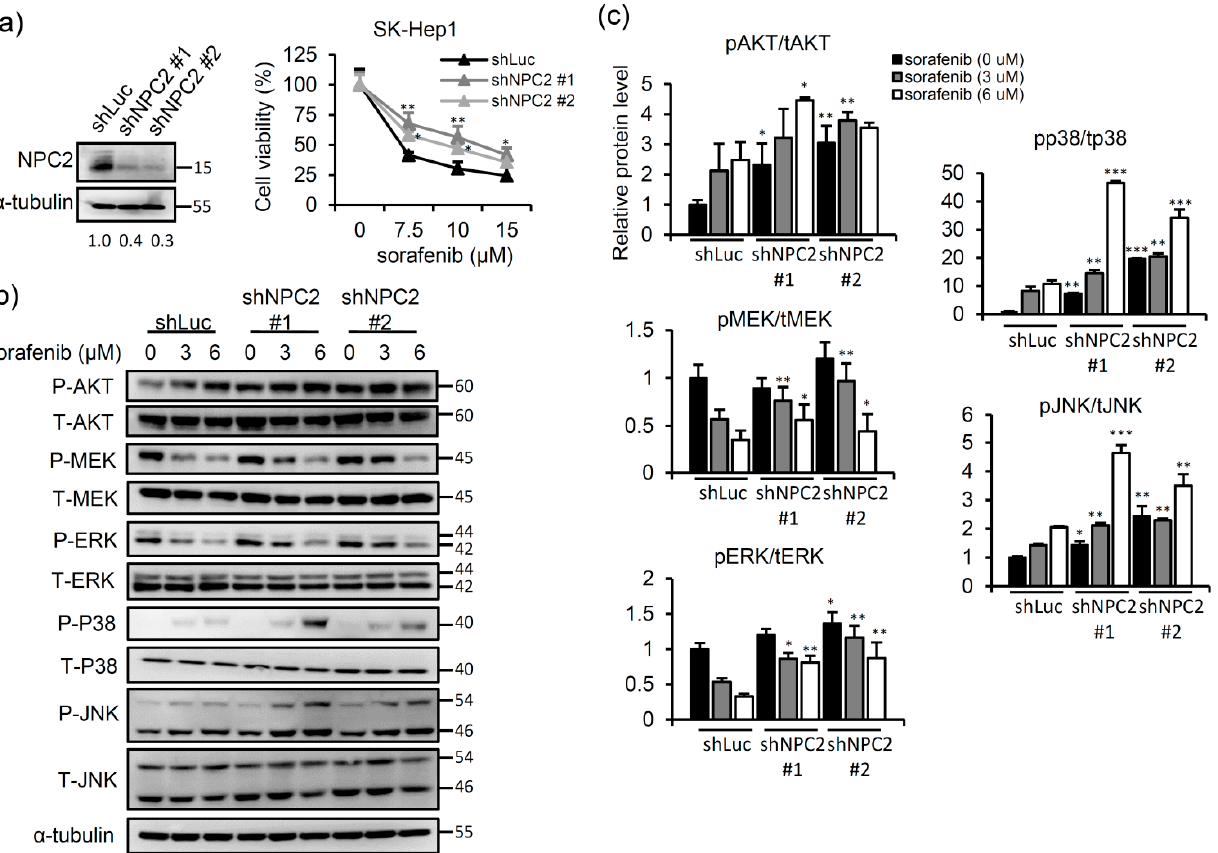
Figure 1. Niemann-Pick type C2 (NPC2) downregulation attenuates sorafenib-induced cytotoxicity through enhancing mitogen-activated protein kinase (MAPK)/AKT signaling in liver cancer cells. ( a ) Western blot analysis was used to confirm the knockdown effect of NPC2. The relative NPC2 intensities are shown under western blot images after normalization with shLuc control intensities. SK-Hep1 cells were treated with 0, 7.5, 10, and 15 μ M of sorafenib for 48 h, and cell viability was assessed with an MTT assay. ( b ) SK-Hep1 cells were treated with 0, 3, and 6 μ M of sorafenib for 48 h, and protein expression levels of AKT, MAPK kinase (MEK), extracellular signal-regulated kinase (ERK), p38, and c-Jun N-terminal kinase (JNK) were detected by western blotting. α -Tubulin was used as an internal control. These experiments were repeated three times with similar results. ( c ) Western blot images were quantified using Image J software. * p < 0.05, ** p < 0.01, *** p < 0.001 compared to shLuc